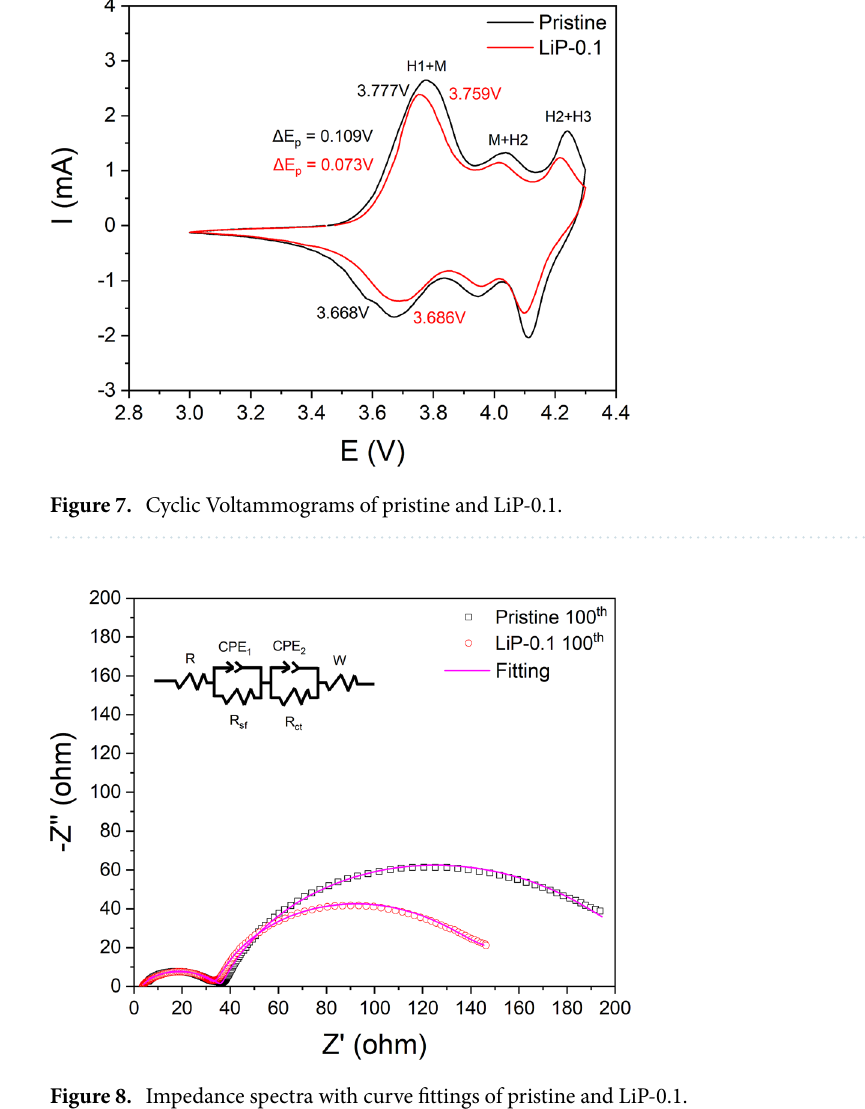
Figure 8. Impedance spectra with curve fittings of pristine and